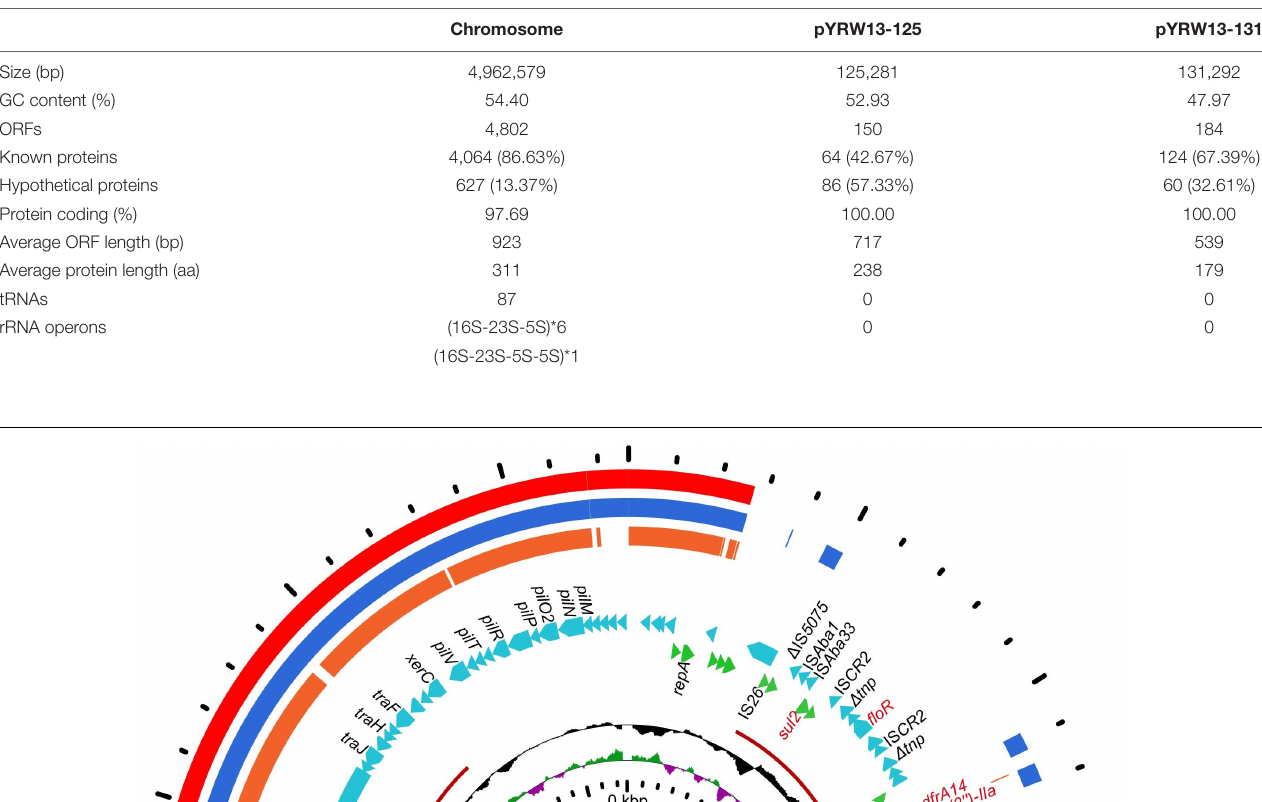
Frontiers in Microbiology |